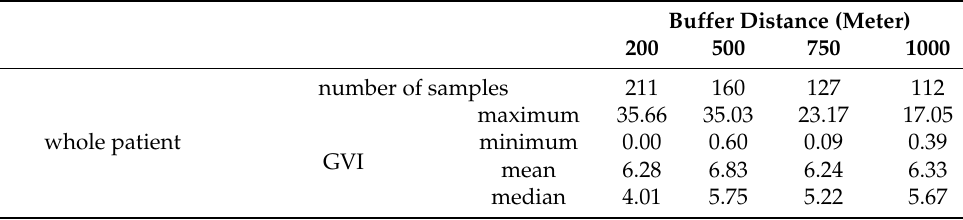
Table 1. Statistical analysis of streetscape features and number of whole patients at different buffer